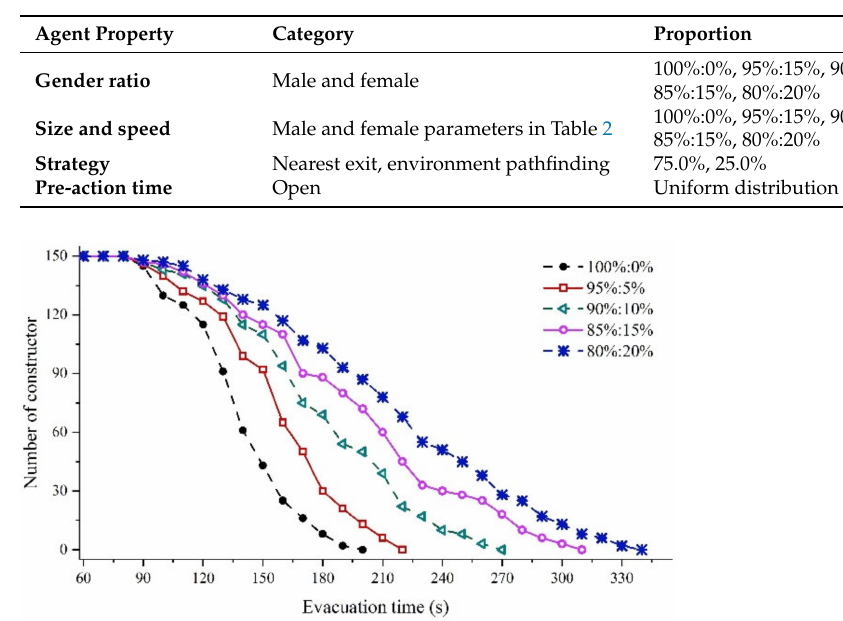
Table 4. Constructor parameters in analysis of gender ratio’s influence.